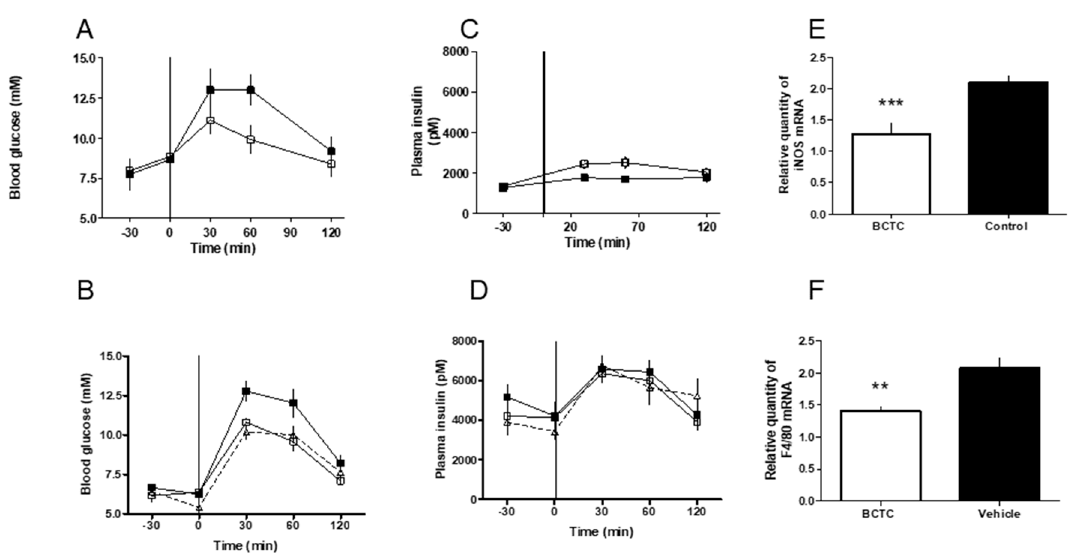
Figure 3. ( A ) The oral glucose tolerance test in male Zucker obese rats after acute oral dosing of the TRPV1 antagonist, BCTC. The rats were given an oral dose of BCTC (15 mg / kg, open squares) or vehicle control (closed squares) by gavage at time − 30 min. At time 0, glucose was given orally by gavage and plasma glucose was determined. ( B ) The oral glucose tolerance in male glucose intolerant Zucker obese rats after chronic oral dosing of the TRPV1 antagonist, BCTC. Groups of 9-month-old rats (10 animals each) were given an oral dose of BCTC, 7.5 mg / kg (open squares) or 15 mg / kg (open triangles), by gavage twice-a-day for 8 days. Control rats received vehicle (closed squares). After the last dose (at time − 30 min), OGTT was performed. At time 0, glucose was given orally by gavage and plasma glucose was measured in blood samples taken from the tail tips of conscious rats. ( C ) Plasma insulin levels in male Zucker obese rats following acute BCTC (open squares) or vehicle (closed squares) treatment. Insulin was determined in blood samples corresponding to ( A ). ( D ) Plasma insulin levels in male Zucker obese rats following chronic BCTC (7.5 mg / kg, open squares; 15 mg / kg, open triangles) or vehicle (closed squares) administration. Measurements in blood samples taken in ( B ). ( E ) At the age of 9 months, the mesenterial fat depots were removed from BCTC-treated and control rats during anesthesia 30 min after the last dosing. Inducible nitric oxide synthase (iNOS) ( E ) and macrophage marker F4 / 80 levels ( F ) were determined as detailed in the Methods